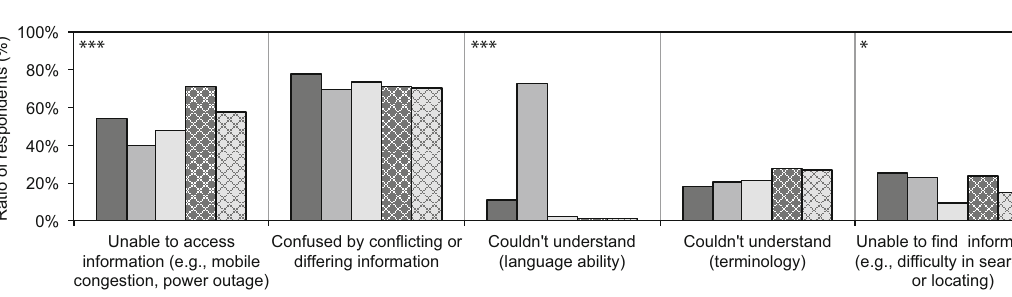
Fig. 5 Sources of information gathering-related difficulties encountered by survey respondents. Chi square significance codes: *** p \ .001, ** p \ .01, * p \